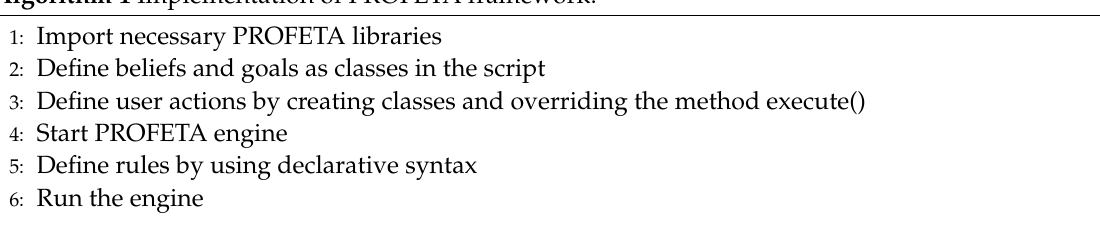
Algorithm 1 Implementation of PROFETA